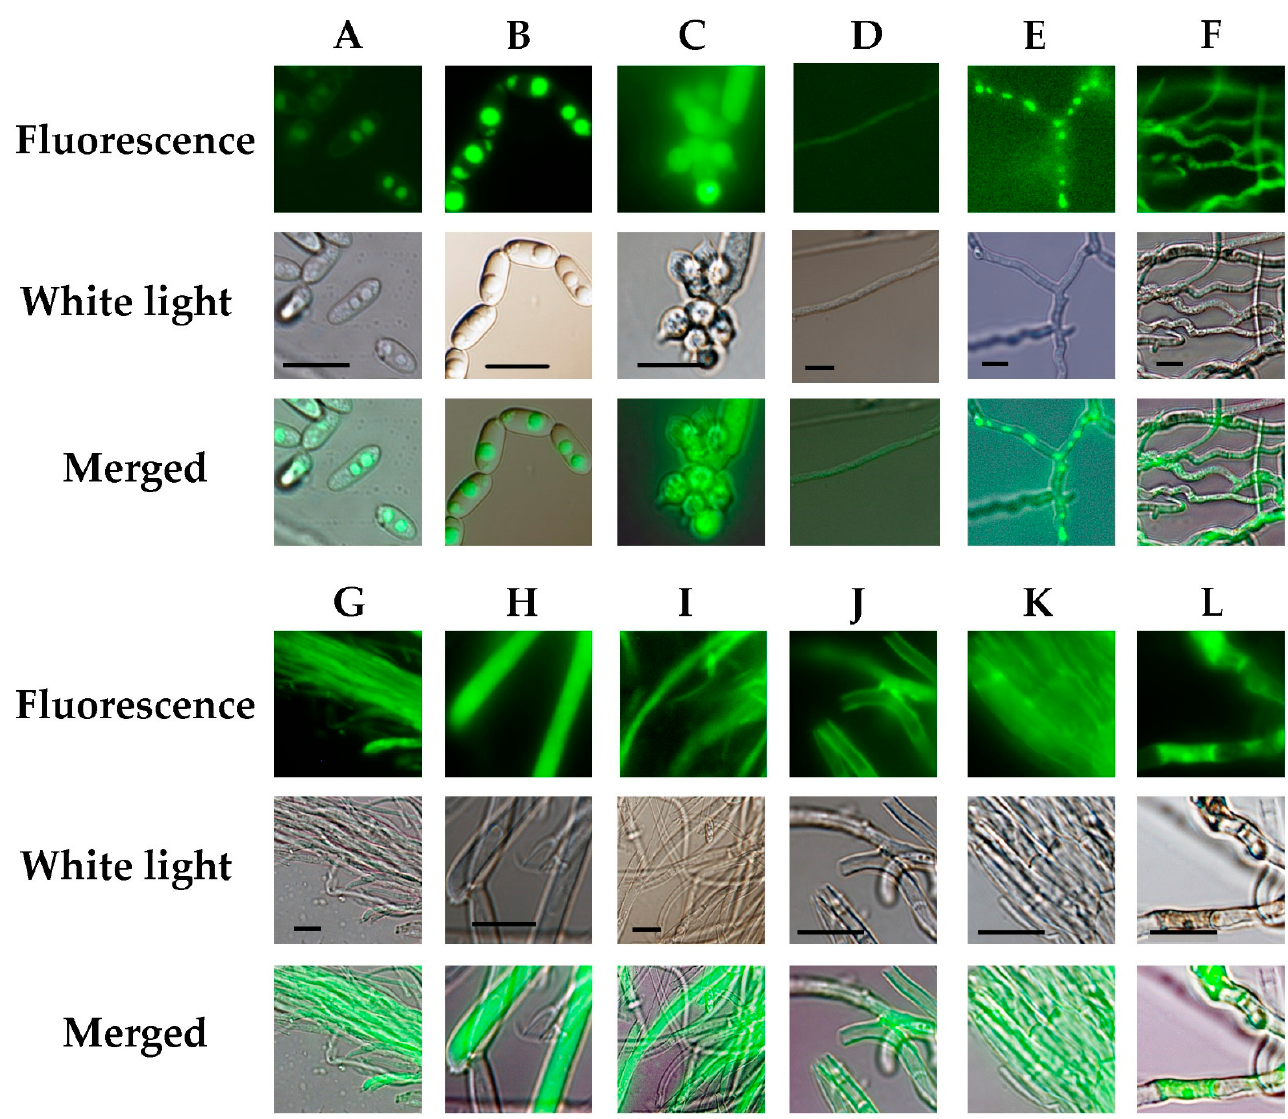
Figure 4. Microscopical analysis of GFP-tagged IcFBR1 in I. cicadae strain ∆ Icfbr1-c . ( A ) Spore staining by BODIPY. ( B – E ) GFP expression when cultured on PDA. ( B ) Spores; ( C ) Conidiophore and phialides; ( D ) Young hyphae, very faint GFP expressed in young hypha cells; ( E ) Old hyphae; ( L ): GFP expression when cultured on rice media. ( F ) Hyphae in young synnemata cultured 8 days after inoculation (DAI); ( G ) GFP expression in synnemal cell with parallel young hyphae; ( H ) Synnemal cells cultured 10 DAI (young synnema); ( I ) Hyphae cultured 14 DAI. ( J ) Synnemal cells (mature synnema) cultured 18 DAI, GFP expression on the cell wall. ( K ) Synnemal cells (mature synnema) cultured 21 DAI, GFP expression on cell wall and septa. ( L ) GFP expressed in mature cells growing from the outside surface of synnema. Bar = 10 µm.